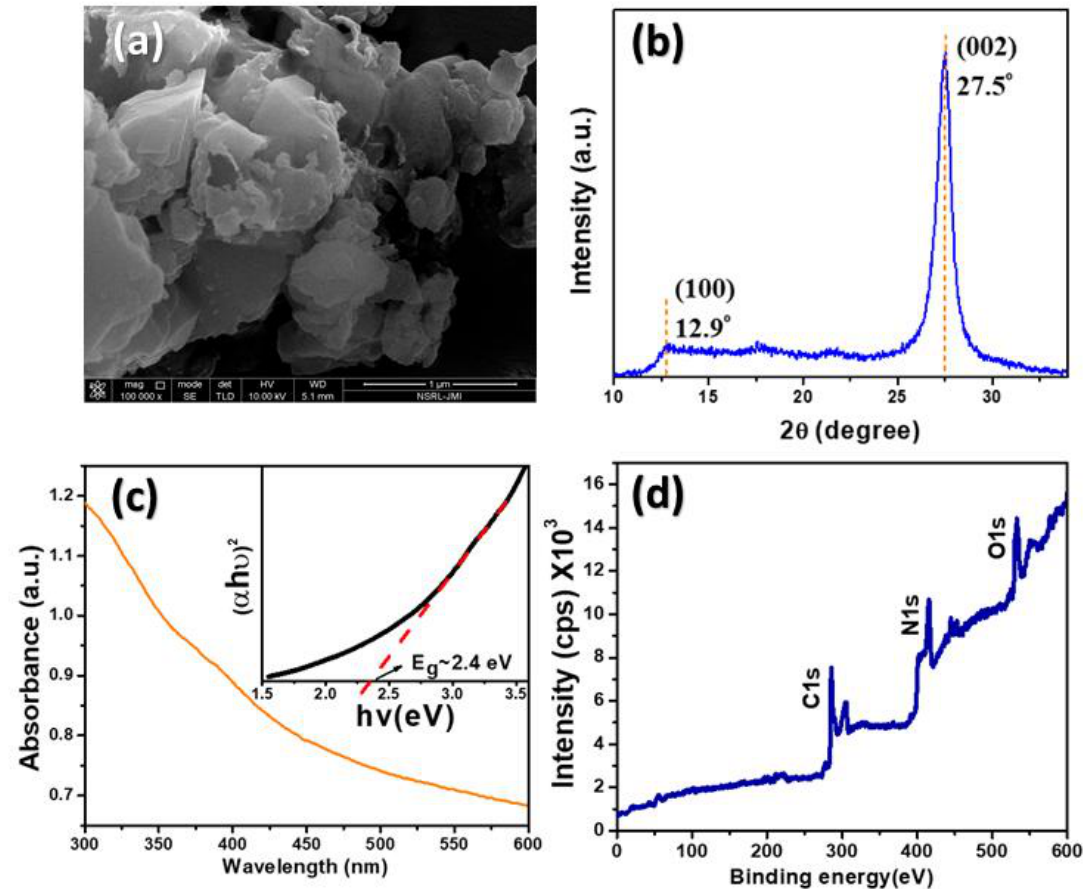
Figure 1. ( a ) FESEM image of Ox-g-C 3 N 4 ( b ) XRD peaks of Ox-g-C 3 N 4 ( c ) UV-visible absorbance spectra (inset: Tauc’s plot) of Ox-g-C 3 N 4 and ( d ) XPS survey scan of Ox-g-C 3 N 4.